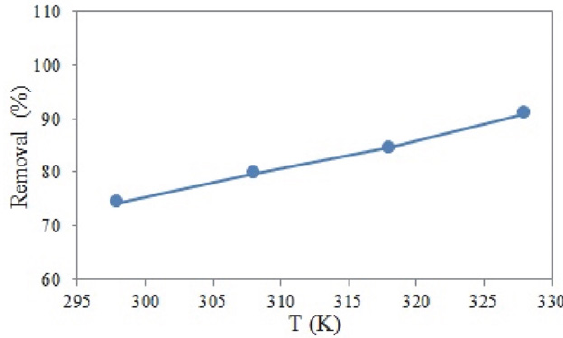
Figure 6. Effect of temperature on MB adsorption by nanozeolite L